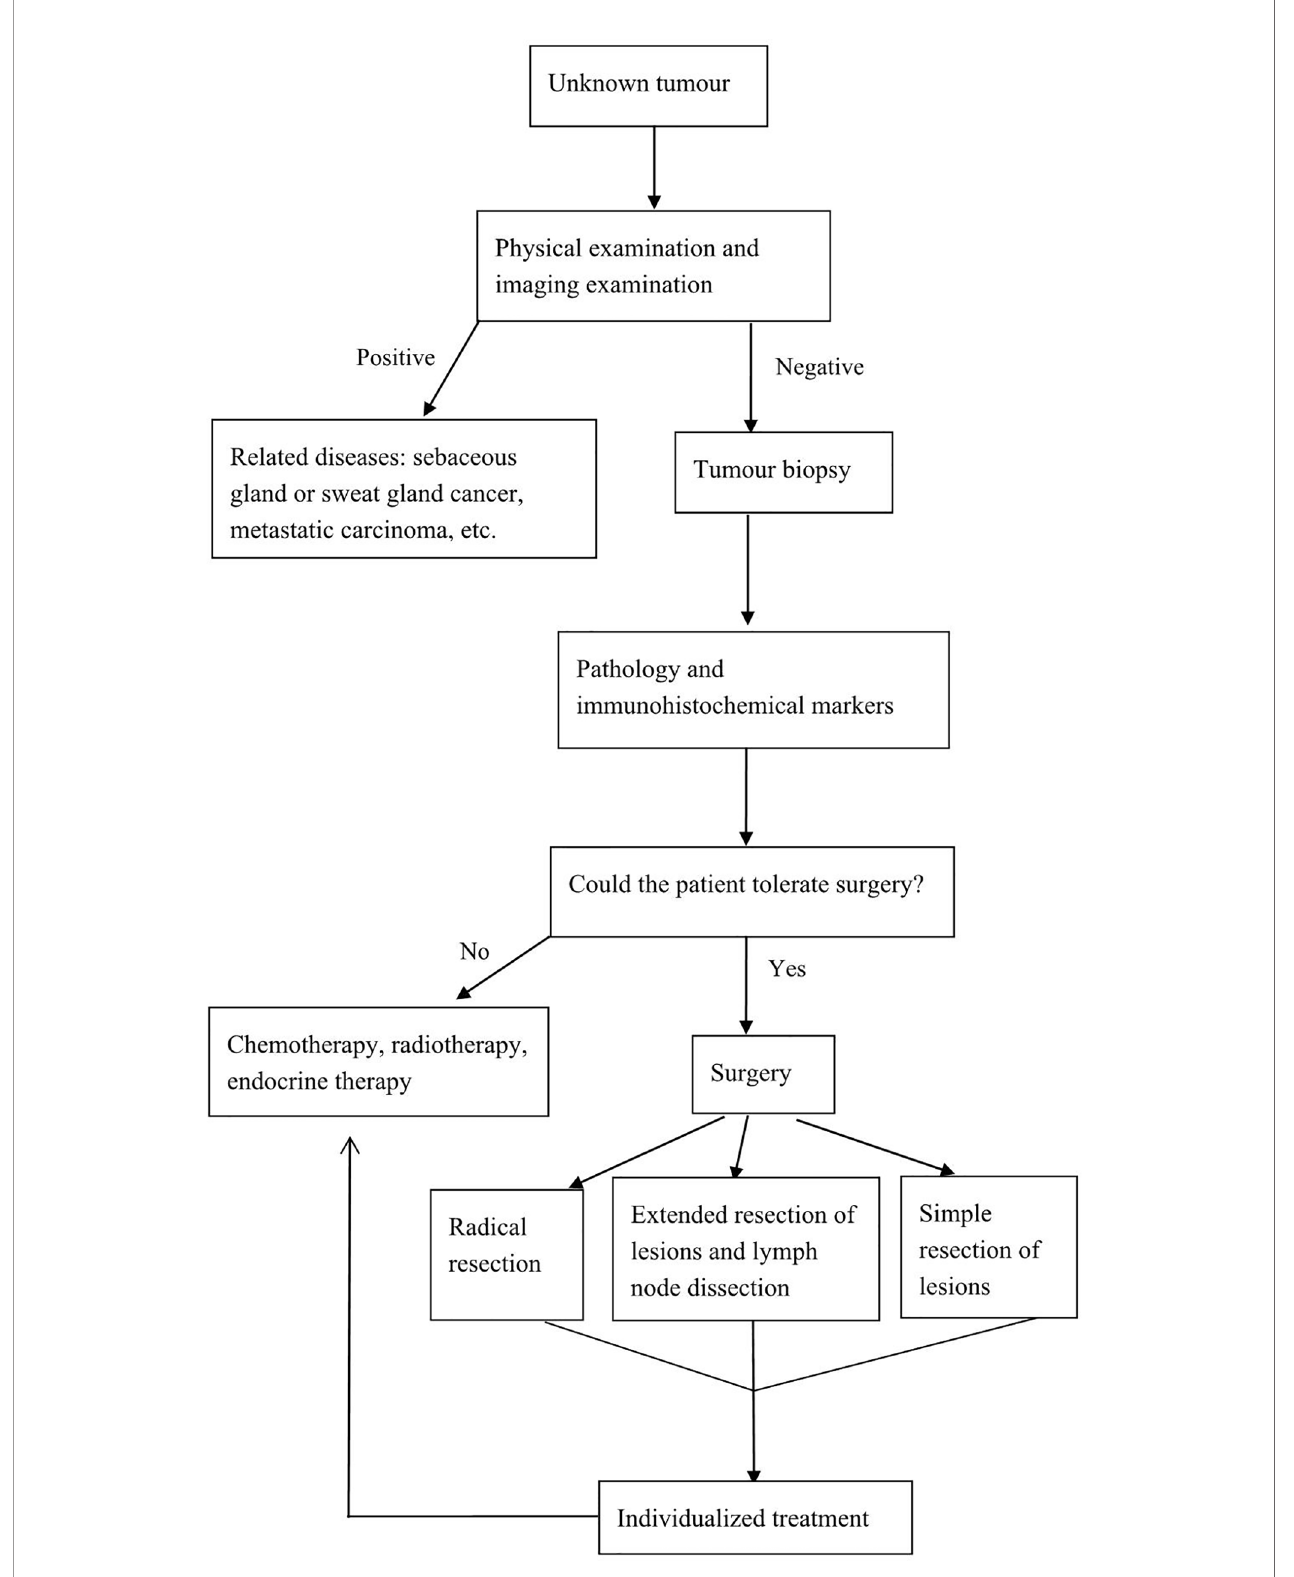
FIGURE 2 | Flow diagram of the diagnosis and treatment